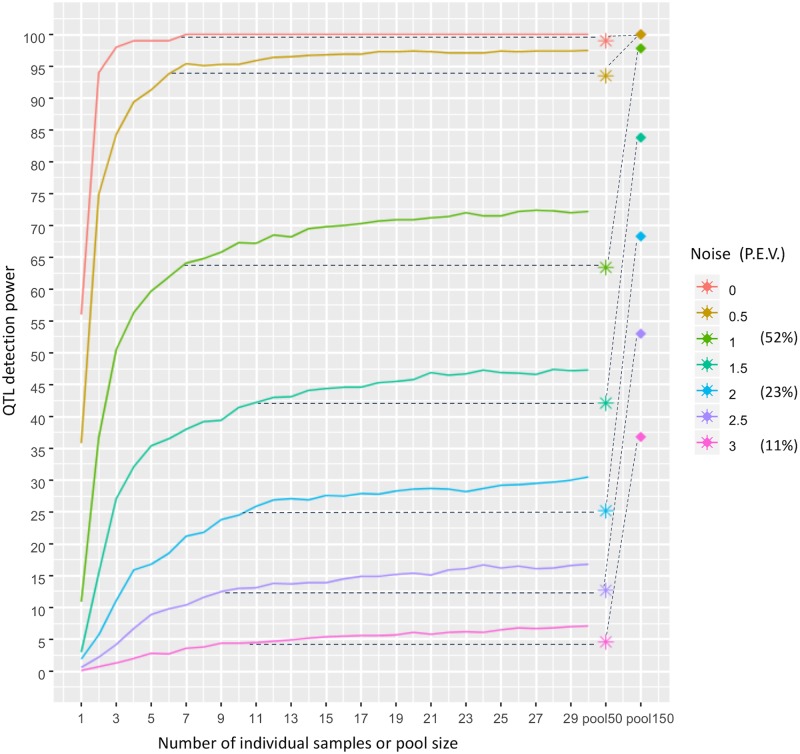
Power of QTL identification.Success rate for detecting a QTL with p<0.05 in 1,000 simulations of 50 colonies (or 150 colonies in the case of the “pool-150” results), with individual sequencing of 1 to 30 samples or pool-seq, and with varying levels of environmental noise. Different colors show different levels of noise that affect the phenotype (P.E.V. = percent explained variation; i.e. the percent of phenotypic variation that is explained by the QTL). The dotted lines illustrate the number of individual samples that provides equivalent power as a pool when only 50 colonies are used, whereas pools for 150 colonies provide much greater power as shown by the diagonal dotted lines.